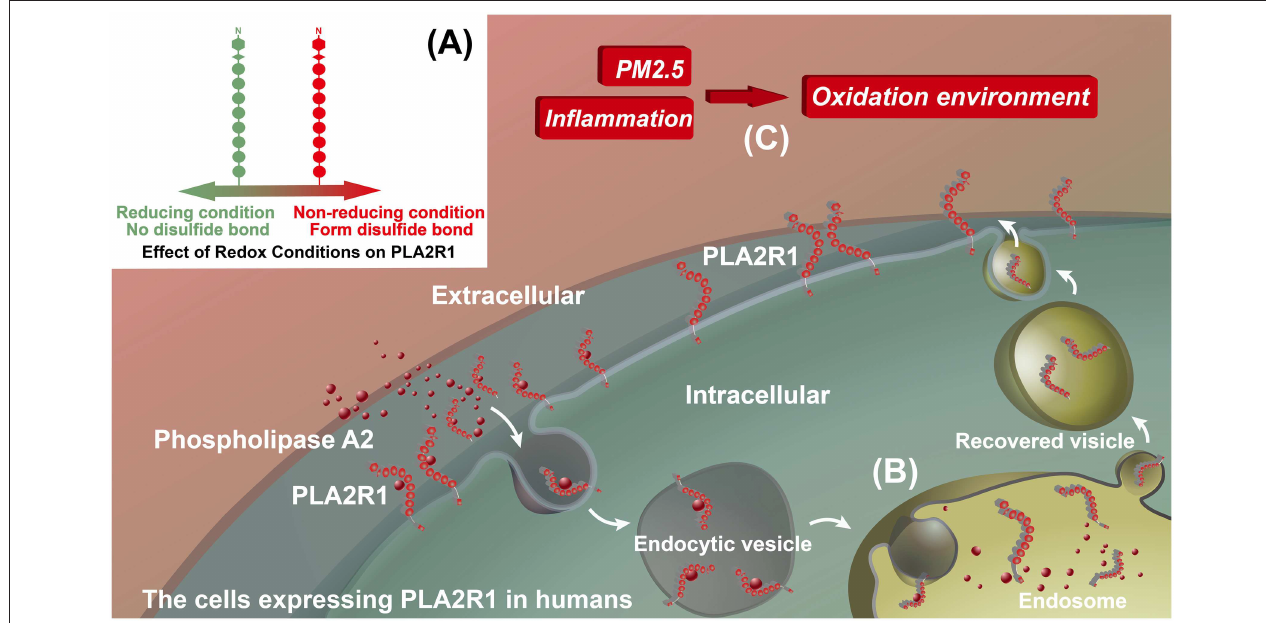
FIGURE 2 | Hypothetical model for the effect of inflammation on PLA2R1. (A) Effect of redox conditions on PLA2R1. PLA2R1 without disulfide bond under reducing condition (Green) and with disulfide bond under non-reducing condition (Red). (B) The potential endocytic property of human PLA2R1. We hypothesize that the extracellular domain of PLA2R1 binds to phospholipase A2 and is transported into the cell by receptor-mediated endocytosis. This model has yet to be supported by any direct evidence. (C) Inflammation, PM2.5, and oxidative microenvironments. We hypothesize that inflammation, including that associated with PM2.5, alters the microenvironment of PLA2R1-expressing cells. PLA2R1 exposed to this oxidative microenvironment may form or retain disulfide bonds resulting the long-term expression of pathogenic